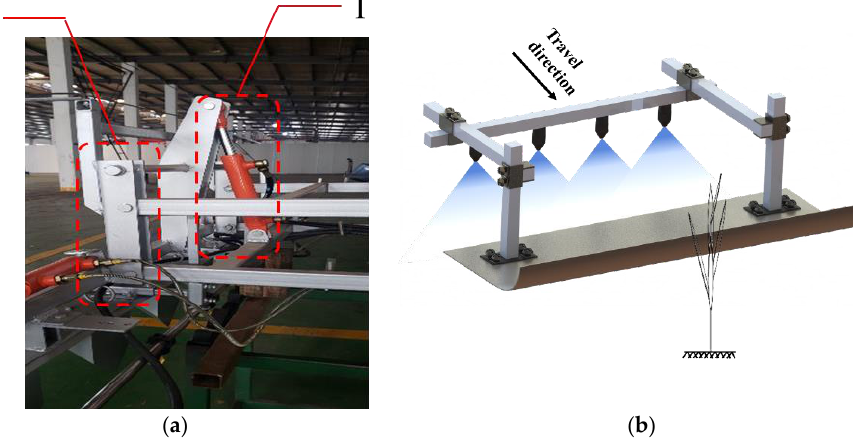
Figure 1. The modified sprayer and the optimization of the canopy-opening device. ( a ) Lifting sys- tem of the canopy-opening device, 1. Lifting or lowering by hydraulic control canopy-opening device; 2. Installation platform of canopy-opening device; ( b ) 3D schematic drawing of the canopy-opening device.